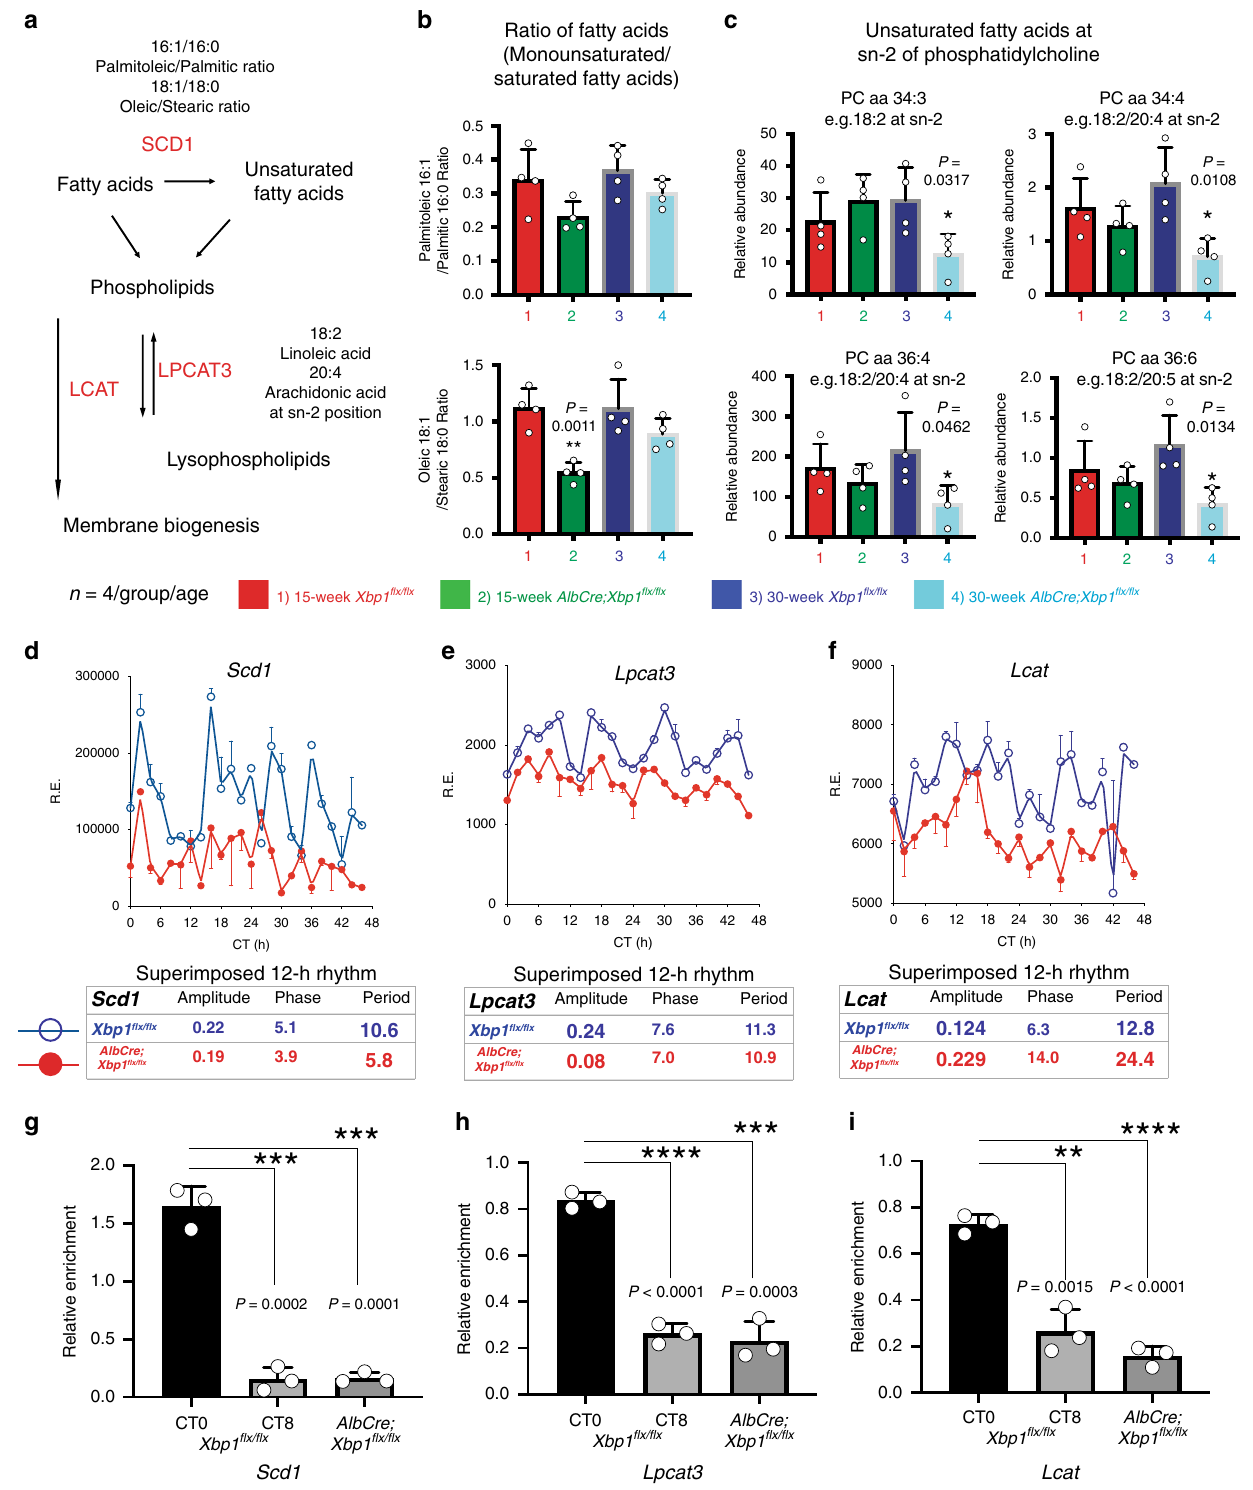
Metabolic pro fi ling using CLAMS . Comprehensive Lab Animal Monitoring System Calorimetry (CLAMS, Columbus Instruments) was used for real-time measurement of RER and food intake. Mice fed ad libitum were acclimated to the chambers for one week prior to data collection. Food intake was monitored for fi ve consecutive days under a 12 h light:12 h dark cycle or constant darkness conditions as speci fi ed. CalR (version 1.2, https://calrapp.org) was used for the analysis of experiments using indirect calorimetry to measure physiological energy balance 58 . Data for VO 2 consumed and VCO2 released were monitored, and RER was cal- culated as VCO 2 /VO 2